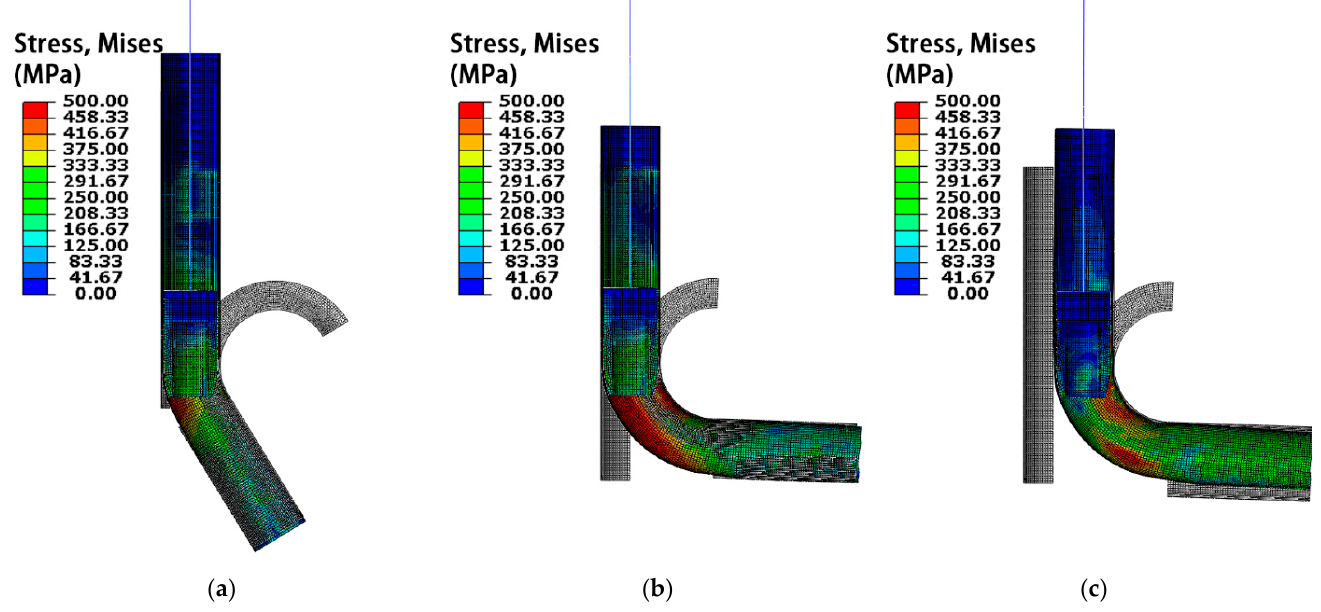
Figure 9. Stress distribution of hollow mandrel scheme 2: ( a ) bending step; ( b ) end of bending step; ( c ) unloading step.